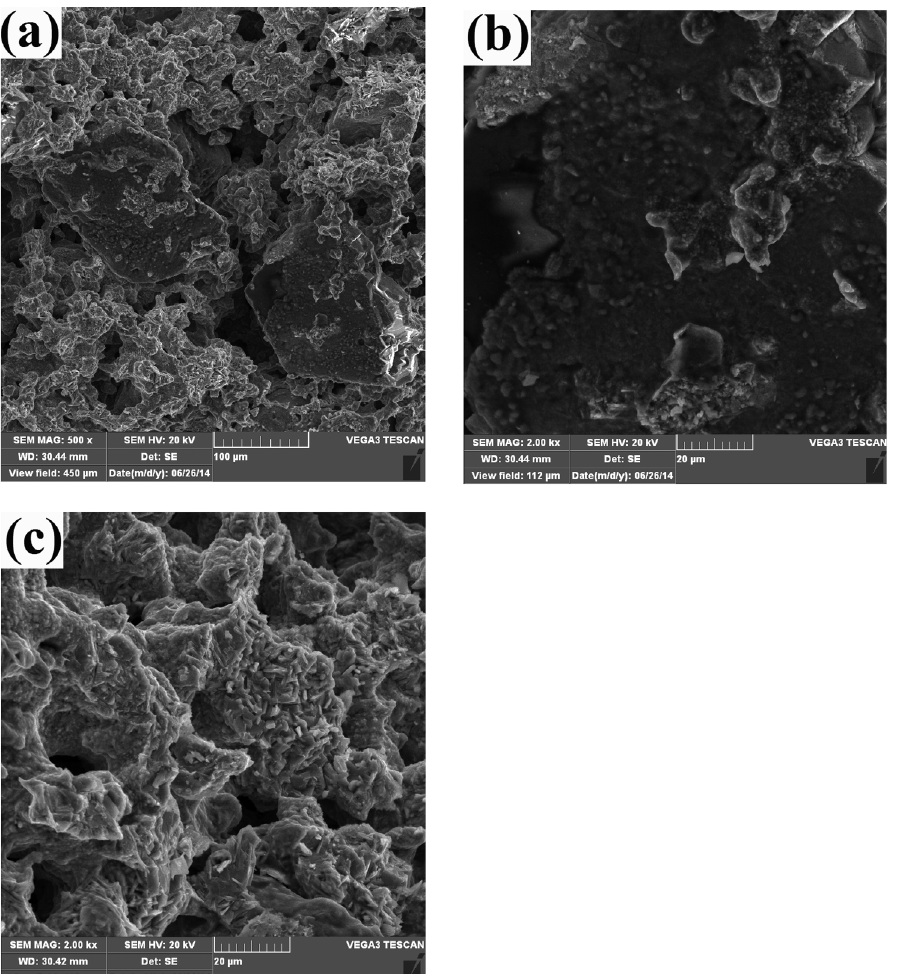
Figure 4: Fracture micrograph of the synthesized sample containing 50% c-BN (120/140